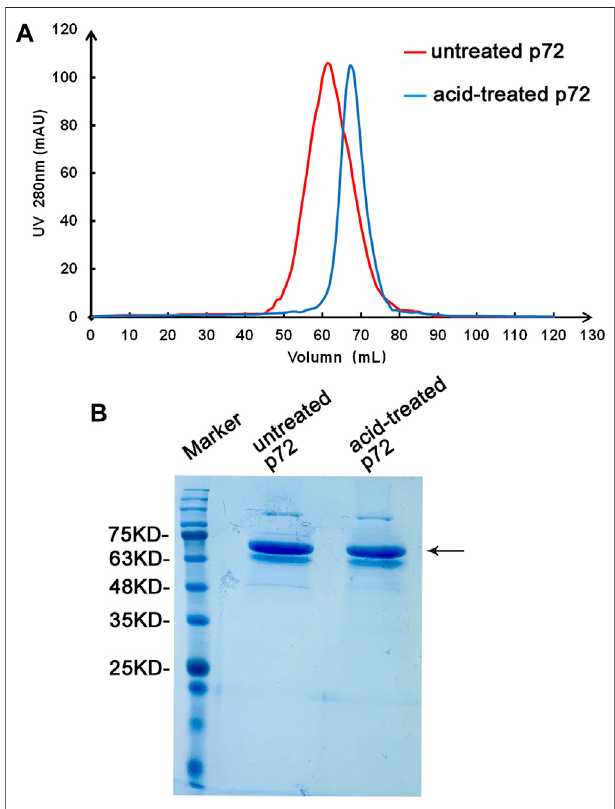
FIGURE 3 | Preparation of the p72 antigen. Analysis of untreated and acid-treated p72 by SEC (A) . The band corresponding to p72 on the stained SDS-PAGE gel (B) is indicated by an